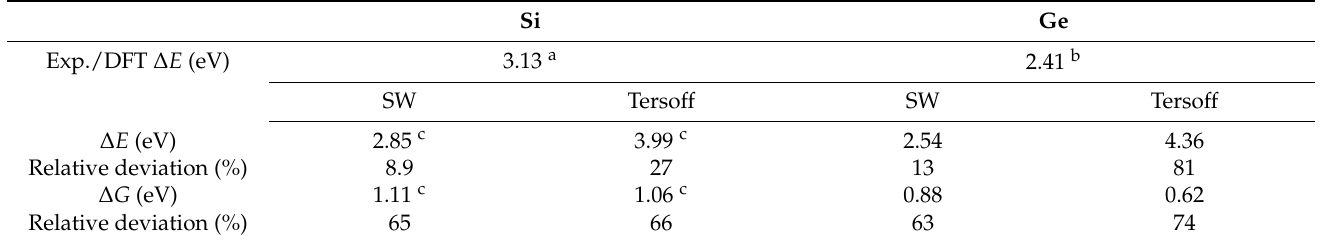
a Average of experimental values in Ref. [27] and Ref. [28]; b Ref. [3] and references therein; c MD simulation